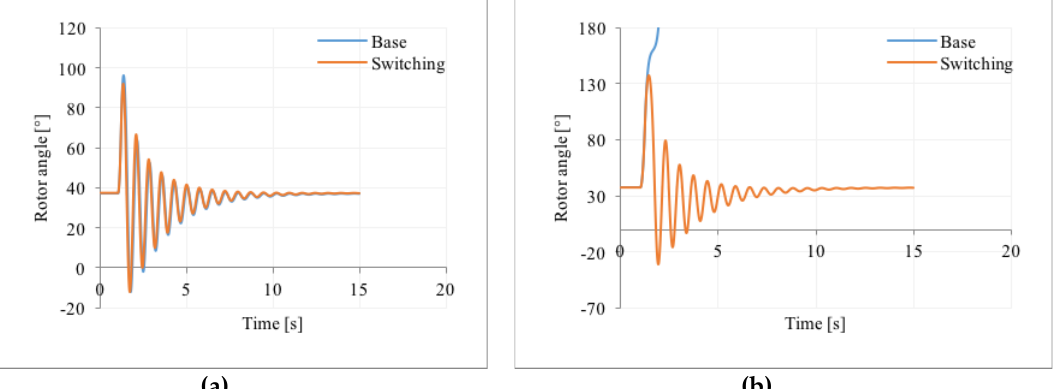
Figure 13. Rotor angle of the synchronous machine of Area 1 for a three-phase fault on Area 2 side: ( a ) Time results for clearing fault time t clear = 170 ms; ( b ) Time results for clearing fault time t clear = 230 ms (critical clearing time t CCT ).